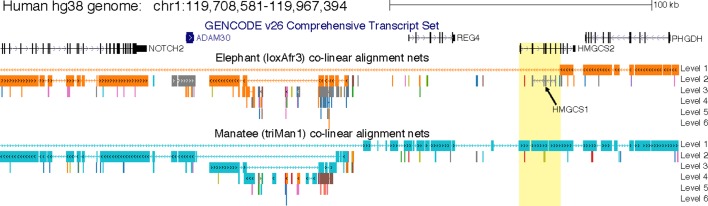
Deletion of a large part of HMGCS2 in elephant.Screenshot of the human UCSC genome browser shows the locus of the NOTCH2, ADAM30, REG4, HMGCS2 and PHGDH genes. Co-linear pairwise alignment chains to the African savanna elephant (loxAfr3 assembly) and the manatee (presumably its closest sister species [Poulakakis and Stamatakis, 2010]) show that several rearrangements, including probably two nested inversions, happened in this locus. Importantly, while NOTCH2, ADAM30 and PHGDH align to both species, the elephant exhibits a large deletion that includes REG4 and most of HMGCS2 (yellow background, see Figure 1B). Alignment chains to the African savanna elephant loxAfr4 assembly are virtually identical and confirm the partial HMGCS2 deletion. The grey elephant chain (arrow) that only aligns exons but not introns of HMGCS2 is the elephant HMGCS1 gene. As described in the main text, searching unassembled reads of 2 individuals of the African savanna elephant (whose genome has been sequenced) and read data of the African forest elephant, the Asian elephant and the mastodon did not reveal any evidence for the presence of the deleted HMGCS2 exons or the REG4 gene, suggesting that this genomic region was already deleted in ancestor of elephants and mastodons.